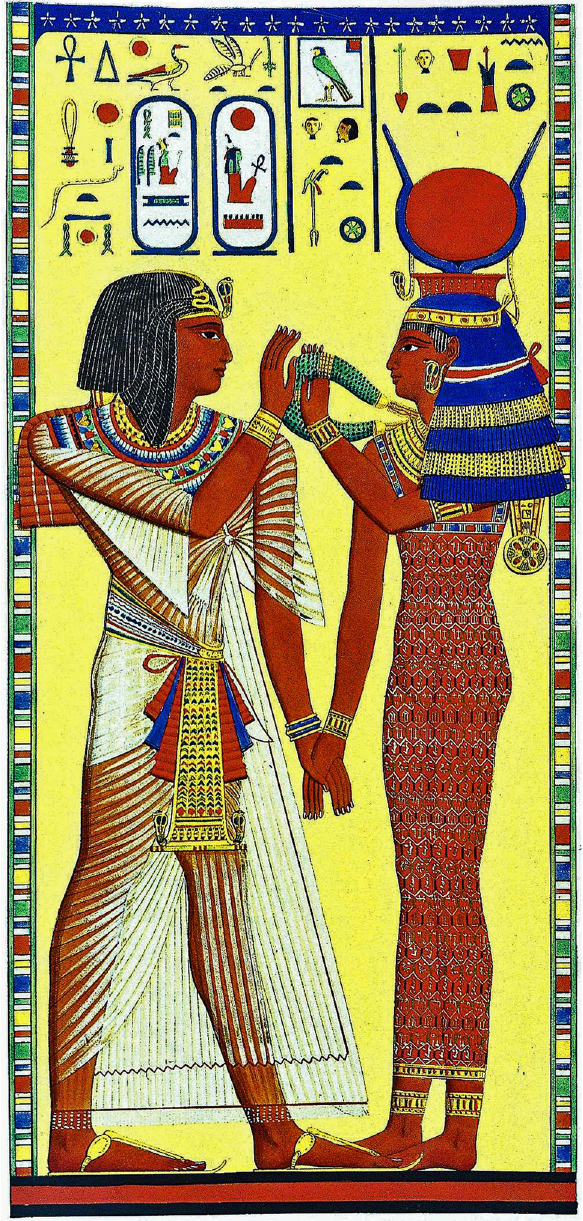
Figure 4. Elevation taken from the digital 3D survey of the wall fragment in its current condition